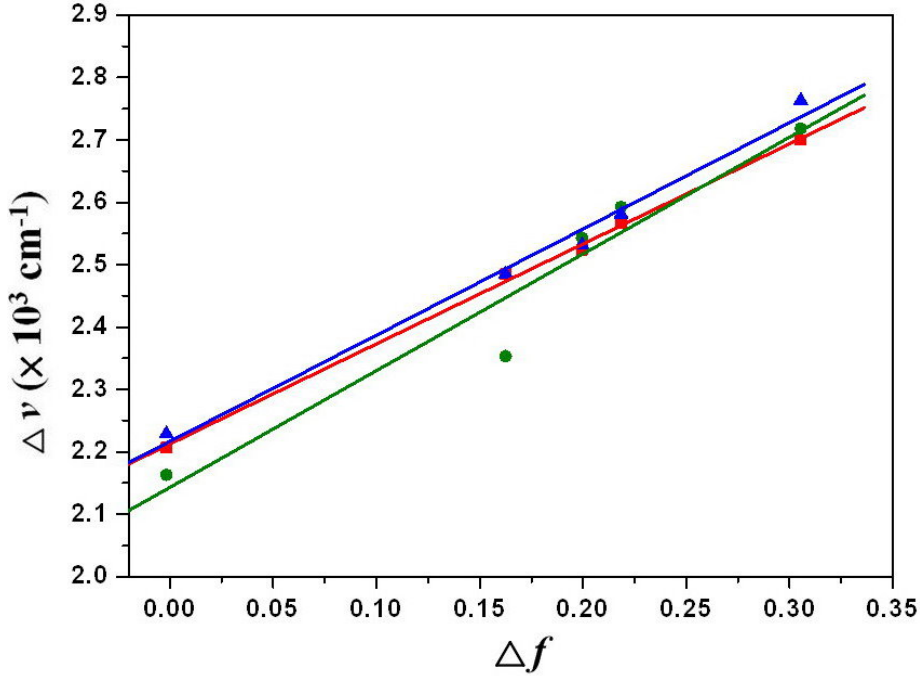
Figure 5. Lippert-Mataga plots for 1a (blue line), 1b (green line) and 1c (red line). The solvents are (1) cyclohexane, (2) diethyl ether, (3) ethyl acetate, (4) dichloromethane and (5)